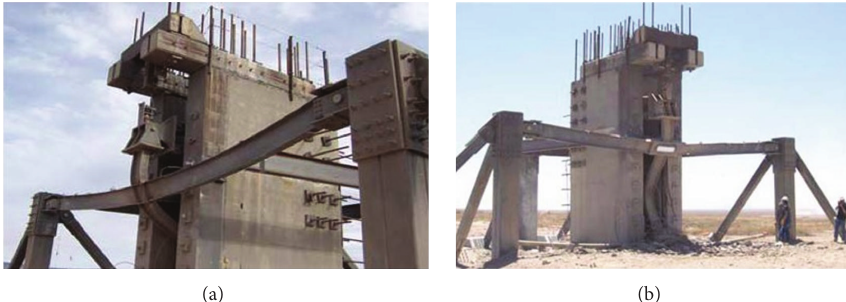
Figure 2: Postblast images of a standard moment connection (a) and a side-plate reinforced blast resistant connection (b)